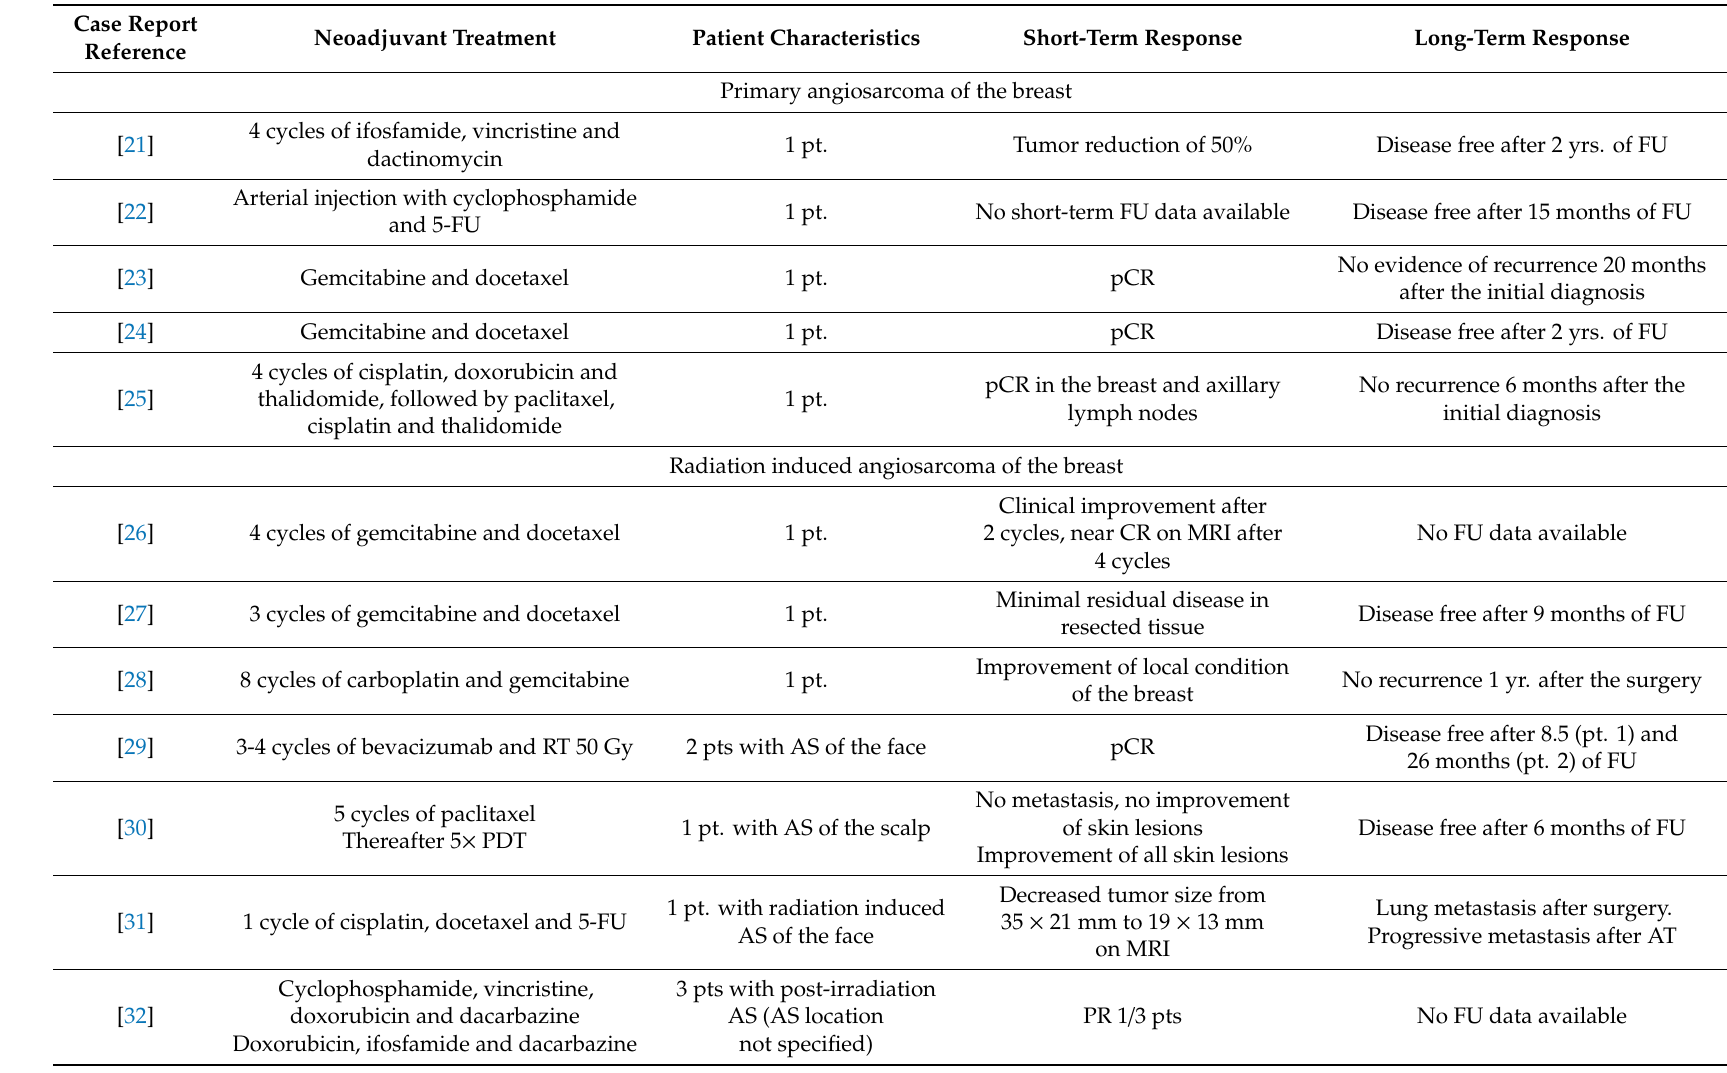
Table 2. Overview of responses to neoadjuvant systemic treatment in angiosarcoma patients—case